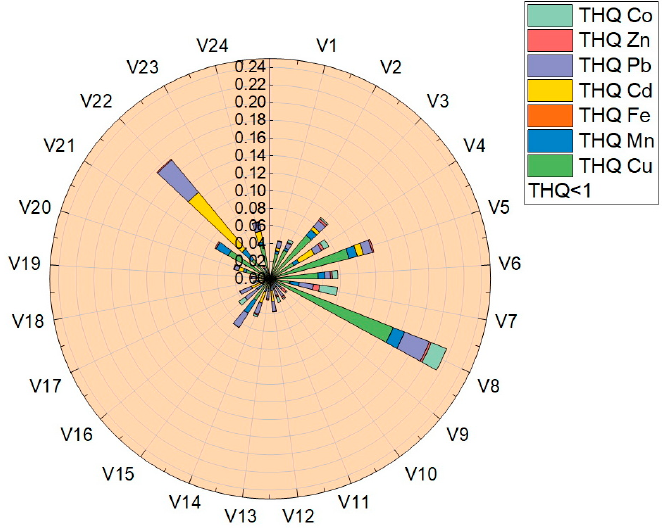
Figure 8. Graphical representation of the target hazard quotient (THQ).